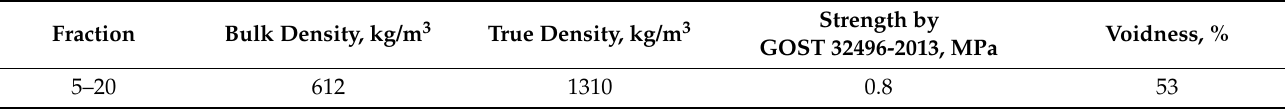
Table 3. Physical and mechanical characteristics of slag pumice.